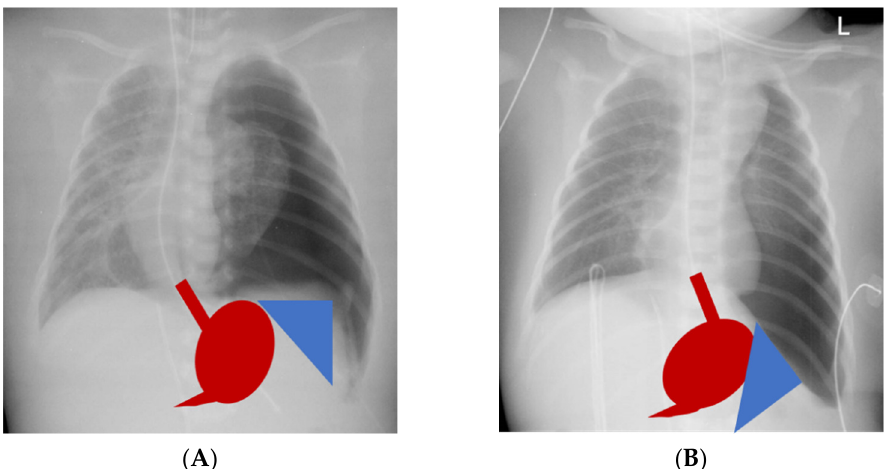
Figure 2. Differences in repositioning of stomach (red) and spleen (blue) after repair of congenital diaphragmatic hernia: ( A ) with a cone-shaped patch, physiologic repositioning, and near-normal angle of His; ( B ) after primary repair under tension or implantation of a plane patch, altered anatomy, and flattened angle of His.